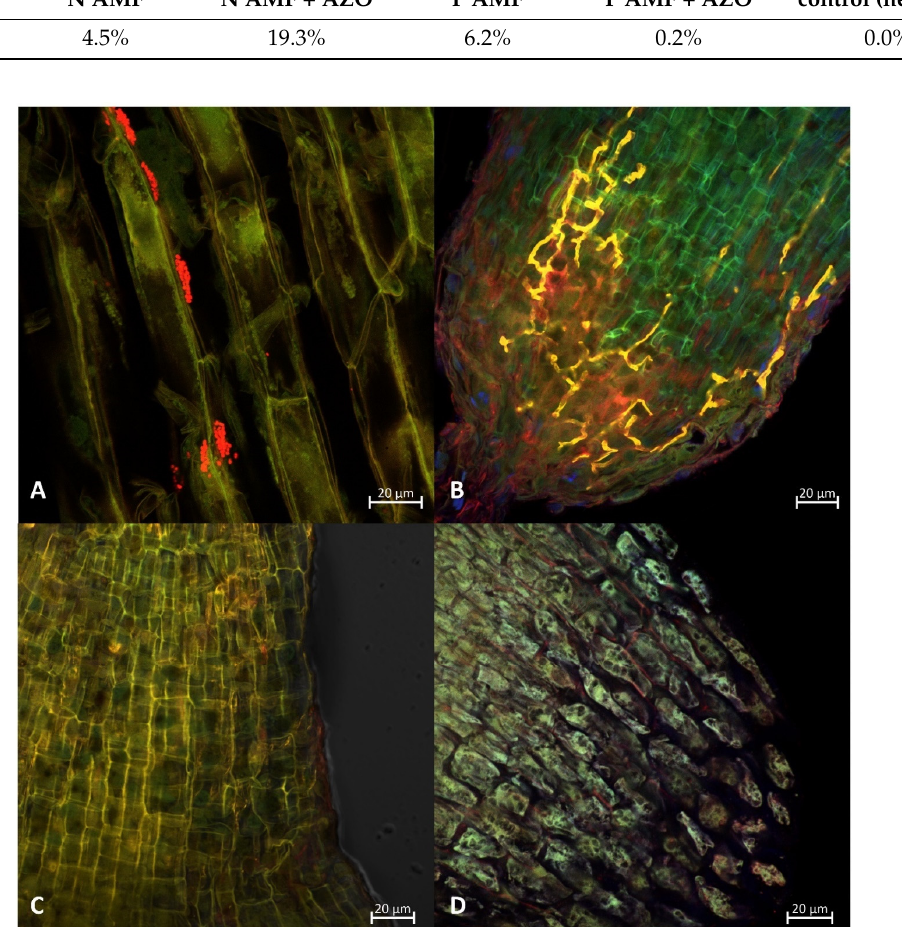
Figure 3. ( A ) Colonies of Azospirillum (in red) on root of pepper non-inoculated with ToBRFV, treated with mycorrhizal fungus and Azospirillum (N AMF + AZO). Scale bar 20 μ m, lens 40×/1.2 NA; ( B ) Arbuscular mycorrhizal fungal mycelia (in yellow) growing inside the root of plant non- inoculated with ToBRFV, treated with Funneliformis mosseae fungus (N AMF). Scale bar 20 μ m, lens 20×/0.8 NA. ( C ) Negative control plants for Azospirillum observation (non-treated with Azospirillum or AMF, non-infected with ToBRFV)). Scale bar 20 μ m, lens 20×/0.8 NA.; ( D ) Negative control plants for AMF observation (non treated with AMF or Azospirillum , non-inoculated with ToBRFV). Scale bar 20 μ m, lens 20×/0.8 NA. Highest colonization of root system by mycorrhizal fungi ( Funneliformis mosseae ) was observed at ToBRFV negative plants treated with both AMF and Azospirillum , where the intensity reached 19.3%. Colonization intensity at both, ToBRFV negative and positive plants treated with AMF only, was 4.5% and 6.2%, respectively. Almost no AMF coloni- zation was observed at ToBRFV positive plants treated with combination of AMF and Azospirillum (Table 4, Figures 3B and 4).